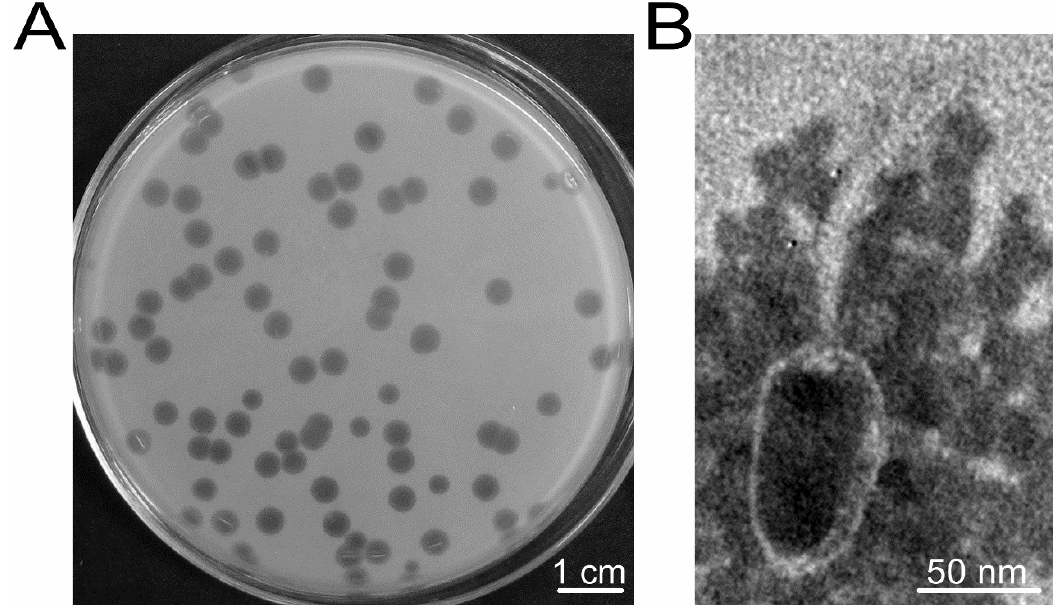
Figure 1. Morphologies of the plaques ( A ) and virion particle ( B ) of the phage vB_BthS_BMBphi.